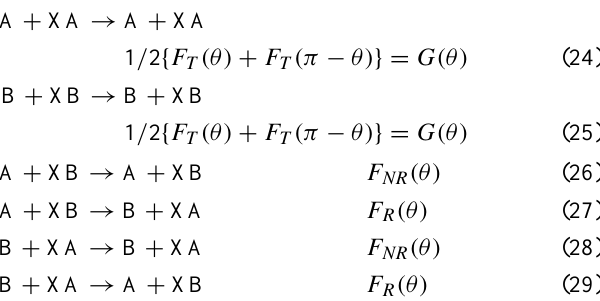
angle where the activated complex cannot possibly stabilize. Since